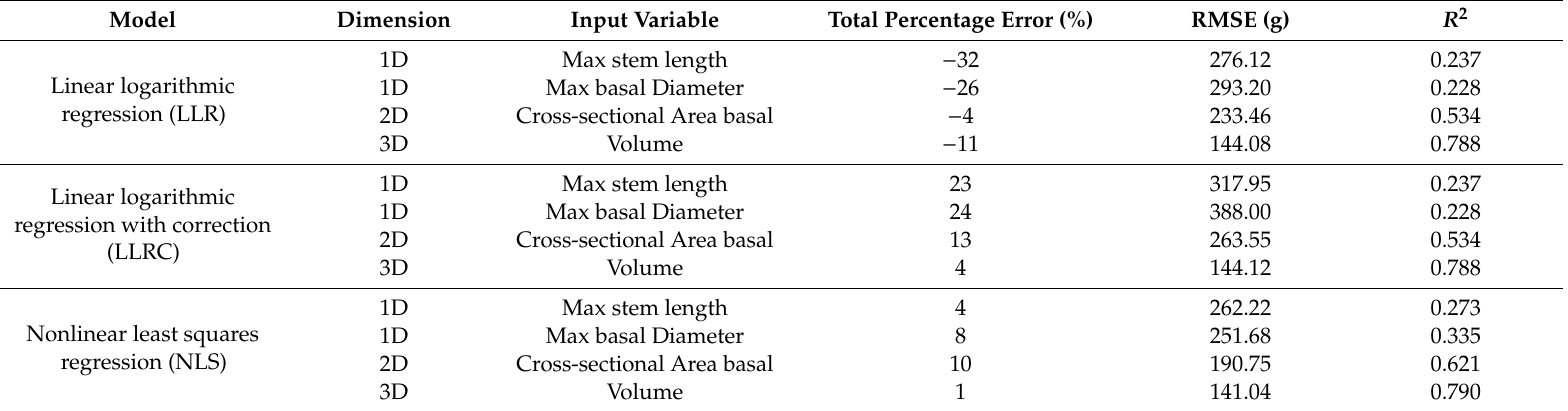
Table 2. Model performances for multispecies shrub total ABG prediction (all p values <